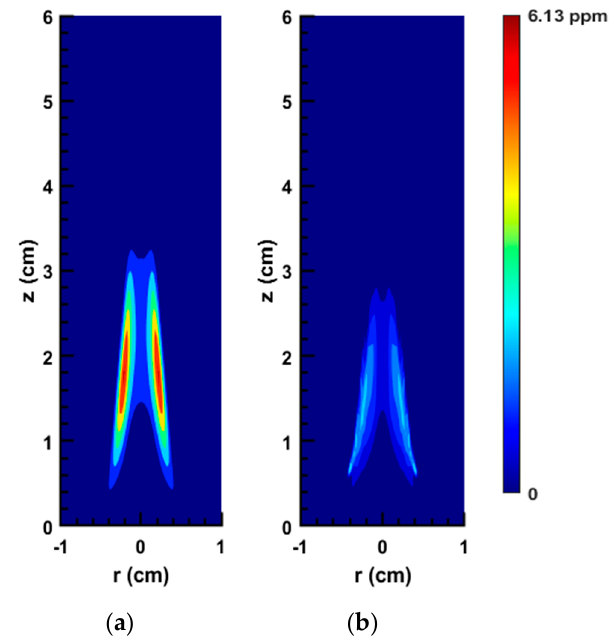
Figure 13. 2D soot concentration field of the CE flame: ( a ) original numerical solution; ( b ) ANN prediction.